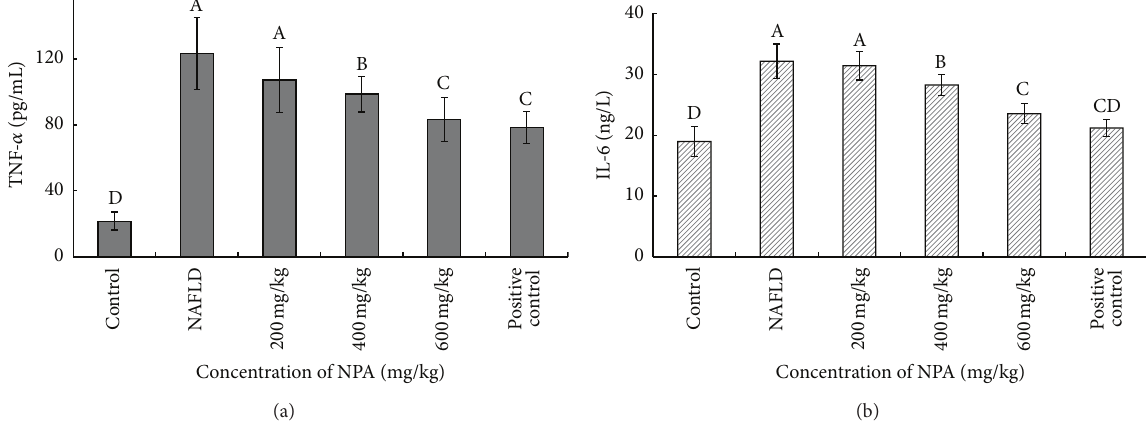
Figure 3: Effect of different concentrations of NPA on serum key inflammatory mediators of TNF- 𝛼 (a) and IL-6 (b) in each group of rats. Different letters (A, B, C, or D) upon each column represent significant differences between the treated groups ( 𝑃 < 0.05